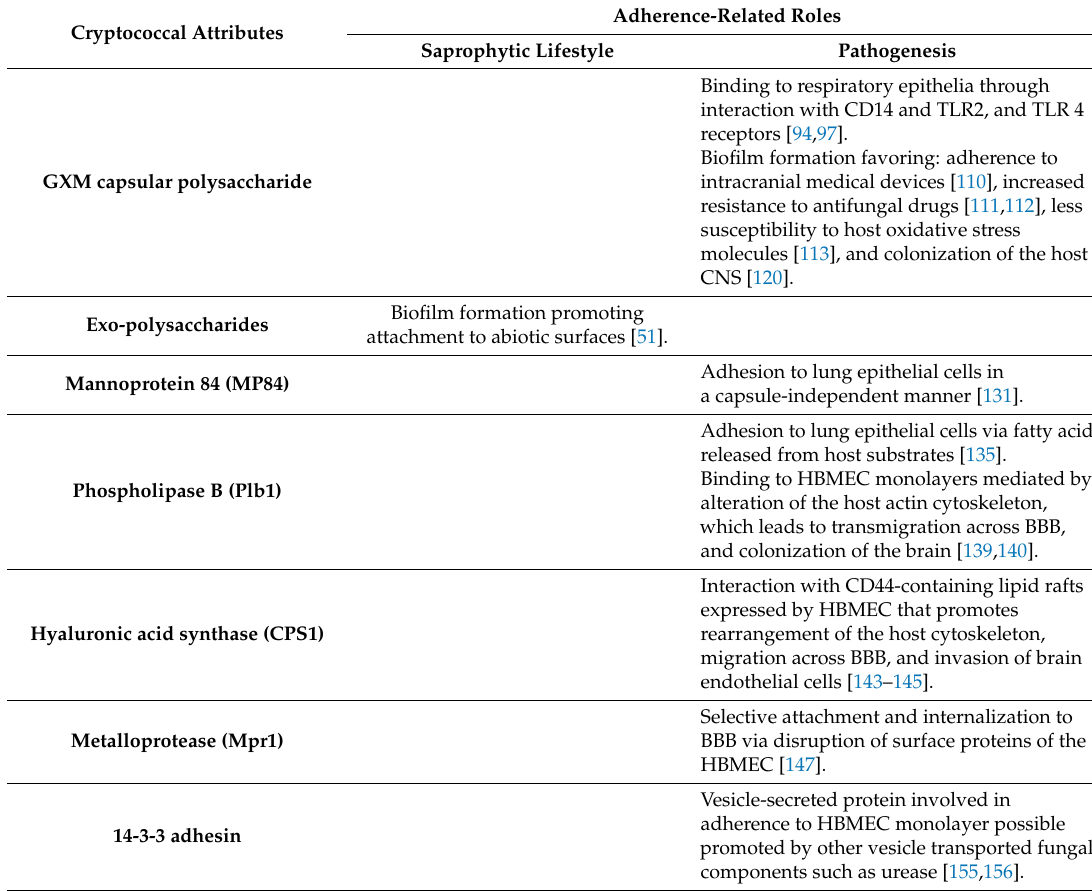
Table 1. Cryptoccocal adhesion tools to biotic and abiotic